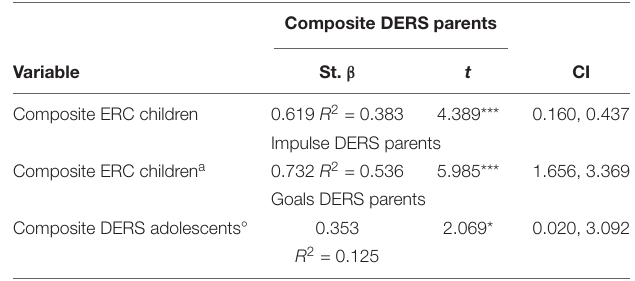
TABLE 9 | Regression model: influences of parent’s emotional regulation on children and adolescent’s emotional regulation (Study